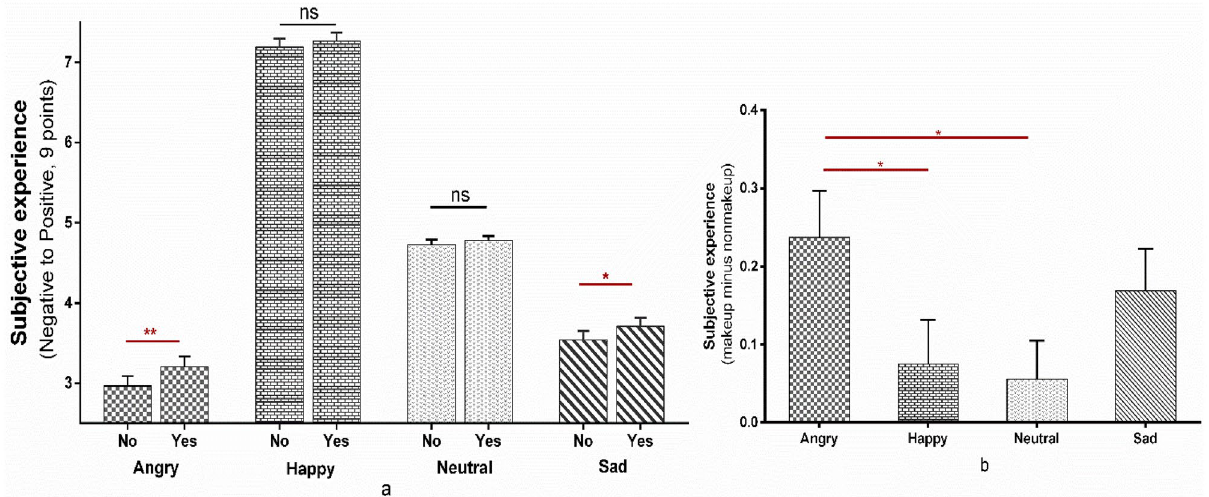
Figure 4. The effect of makeup on emotional contagion in Experiment 2. ( a ) The effect of makeup on different emotional contagion. “Yes” refers to makeup conditions, and “No” refers to non-makeup conditions. ( b ) The differences of increments induced by makeup among emotions. The error bar represents standard error. “*” p < 0.05, “**” p < 0.01, “***” p <